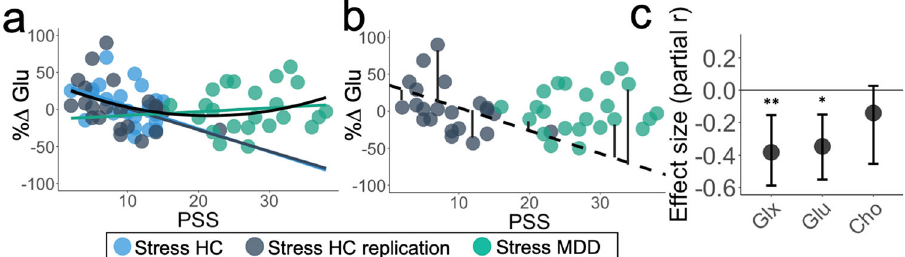
Fig. 3 Relationship between perceived stress and MRS metabolites. a Relationship between PSS and change in creatine-normalized glutamate in all participants who completed the acute stress manipulation. Group-level linear trends (colors) and combined quadratic effect (black) are overlaid. b Maladaptive glutamate response was calculated for the healthy control stress replication sample (gray) and participants with major depressive disorder (green), de fi ned as the residual between the observed percent change glutamate and expected percent change glutamate, estimated using the linear function of the healthy control stress sample, shown in black. Percent change glutamate expected = 35.647 − 3.093*PSS. c Partial effect size (Pearson ’ s r ; controlling for age and sex, two-tailed, uncorrected) between PSS and percent change glx (glutamate and glutamine; r partial(43) = − 0.382, p = 0.010), percent change glutamate ( r partial(43) = − 0.346, p = 0.020), and percent change choline-containing metabolites ( r partial(43) = − 0.141, p = 0.356) in all healthy controls who completed the acute stress manipulation ( n = 47 participants). Signi fi cance indicated as * p < 0.05 , **p < 0.01. Estimates and error bars (95%CI) were estimated using bootstrapping with 1000 samples. Cho Choline-containing metabolites (primarily glycerophosphocholine and phosphocholine), Glu Glutamate, Glx Glutamate + Glutamine, HC Healthy Control, MDD Participants with major depressive disorder, MRS Magnetic Resonance Spectroscopy, PSS Perceived Stress Scale. Source data are provided as a Source Data fi